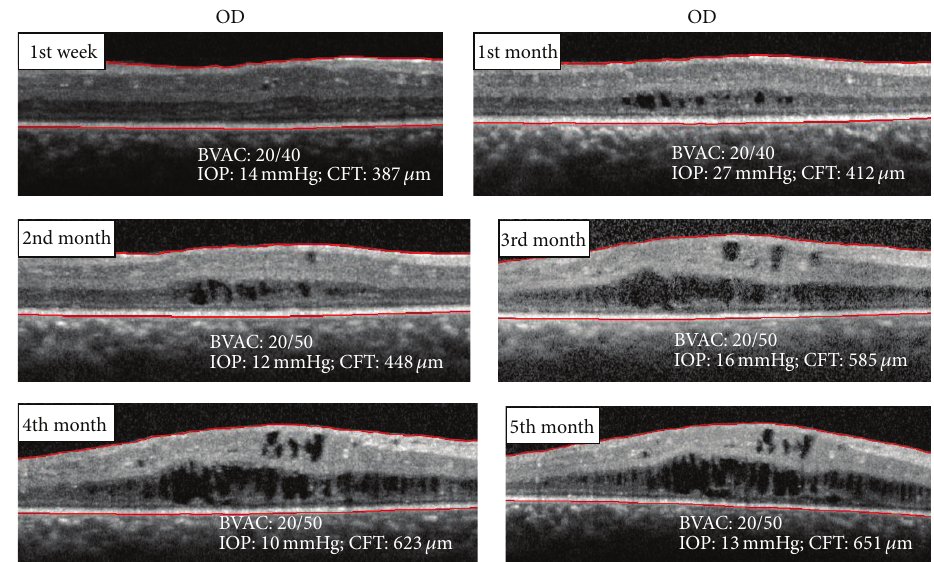
Figure 7: OCT spectral domain OD after intravitreal injection of triamcinolone.